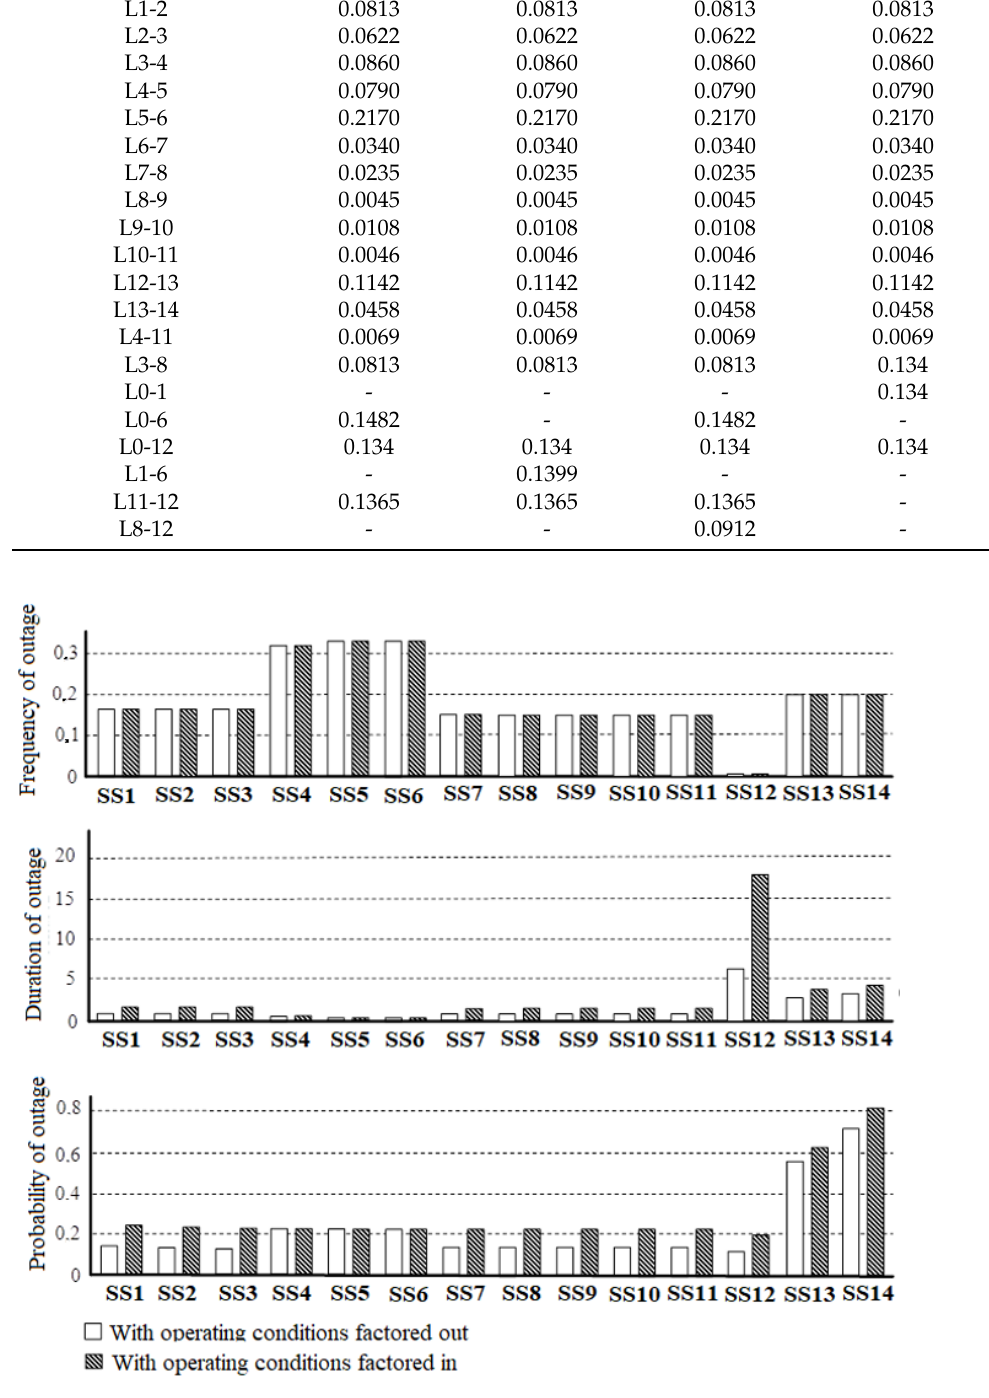
Figure 7. Reliability metrics for Structure 1 of the distribution network.